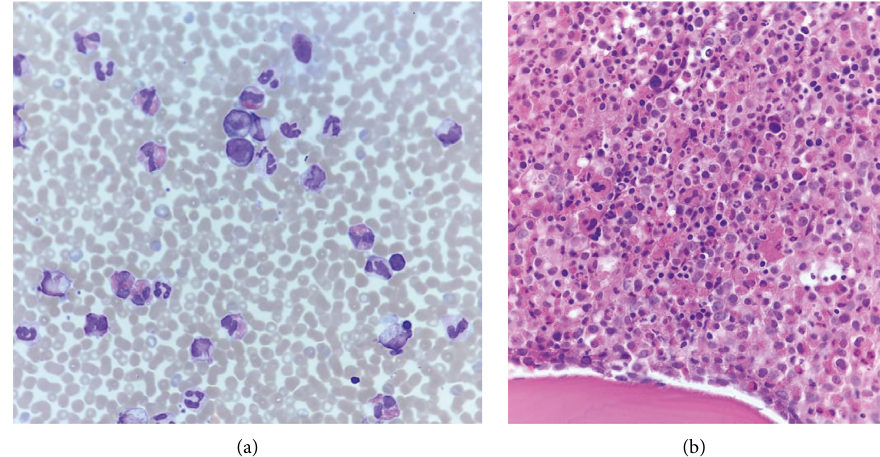
Figure 1: (a) Peripheral blood smear demonstrating a leukocytosis with myeloid left shift, basophilia, eosinophilia, polycythemia, and thrombocytopenia; Wright-Giemsa, original image 1,000, oil immersion. (b) High-power image of the bone marrow biopsy highlighting × the dramatic myeloid predominance with only few, rare erythroid precursors and small, hypolobated megakaryocytes; hematoxylin-eosin, original image 500, oil immersion. ×